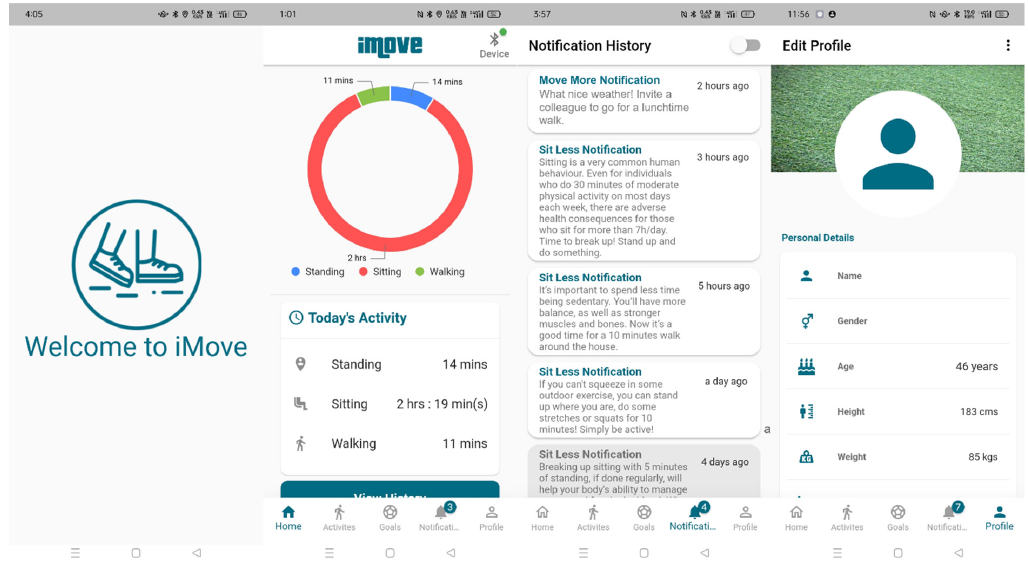
Figure 3. iMOVE app images after